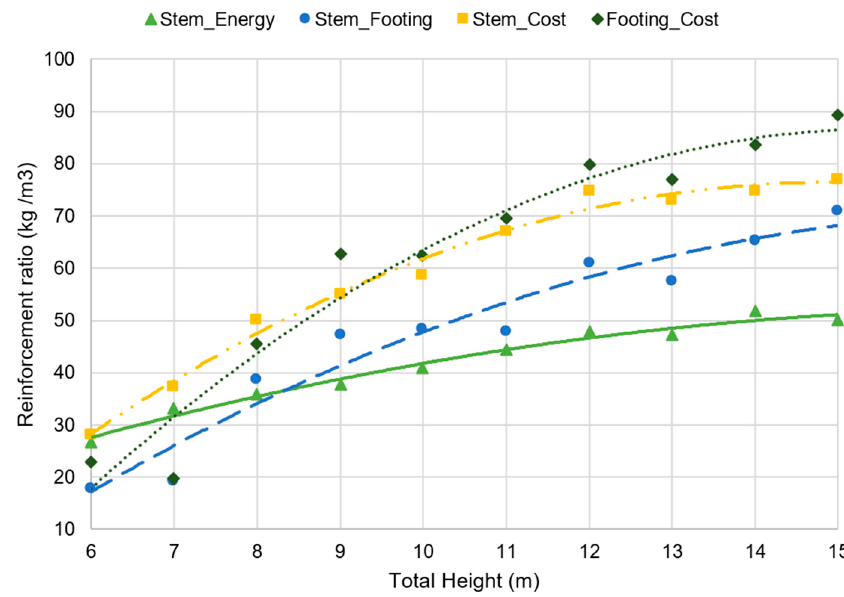
Figure 9. Relation between reinforcement ratio and wall height.